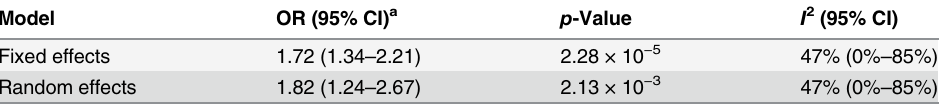
Table 3. Mendelian randomization estimate of the association of decreased 25OHD with the risk of multiple sclerosis excluding the DHCR7 locus. Model